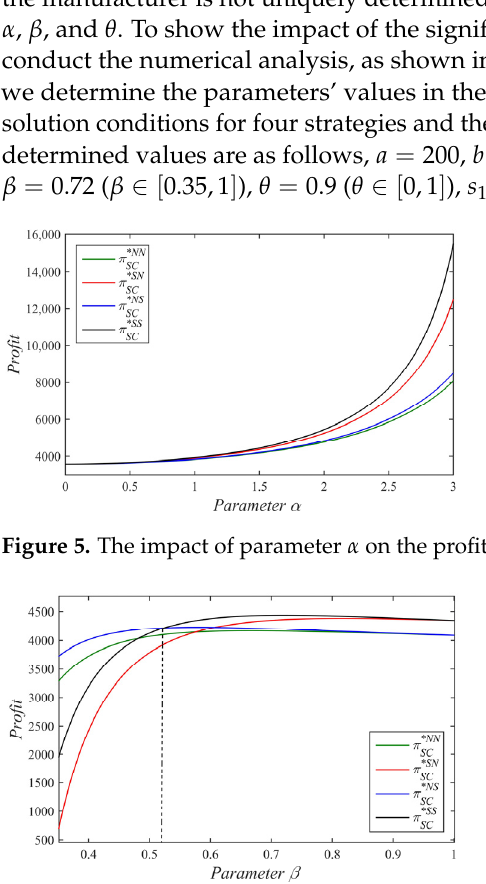
β β on the profits of supply chain. on the profits of supply chain. Figure 6. The impact of parameter β on the profits of supply chain.